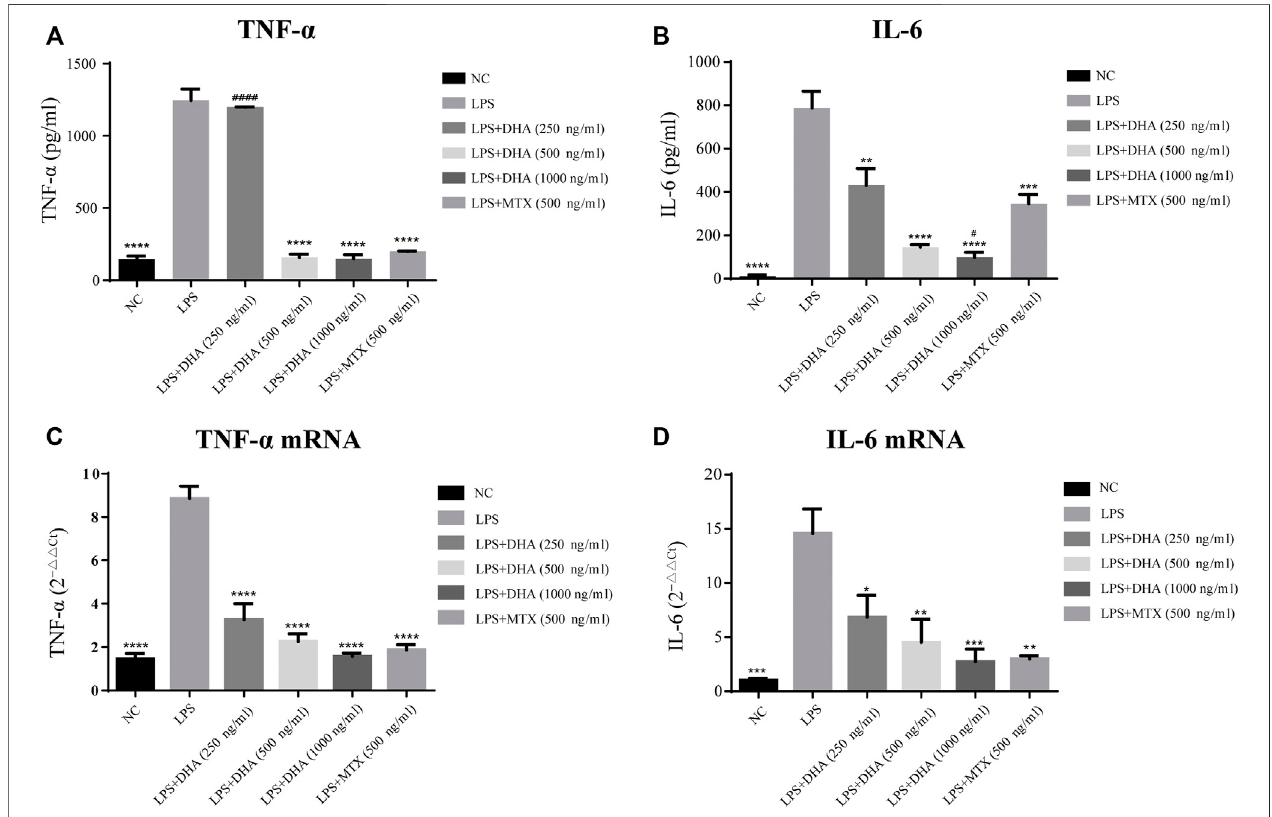
FIGURE 3 | DHA inhibited the protein and mRNA expression of in fl ammatory cytokines in ST486. (A,B) The protein expression level of TNF- α and IL-6 were detected by ELISA. (C,D) The mRNA expression level of TNF- α and IL-6 were detected by qRT-PCR. The experiments were repeated three times and analyzed using one-way ANOVA. * p < 0.05, ** p < 0.01, *** p < 0.001 and **** p < 0.0001 vs. the LPS group; # p < 0.05 and #### p < 0.0001 vs. the MTX